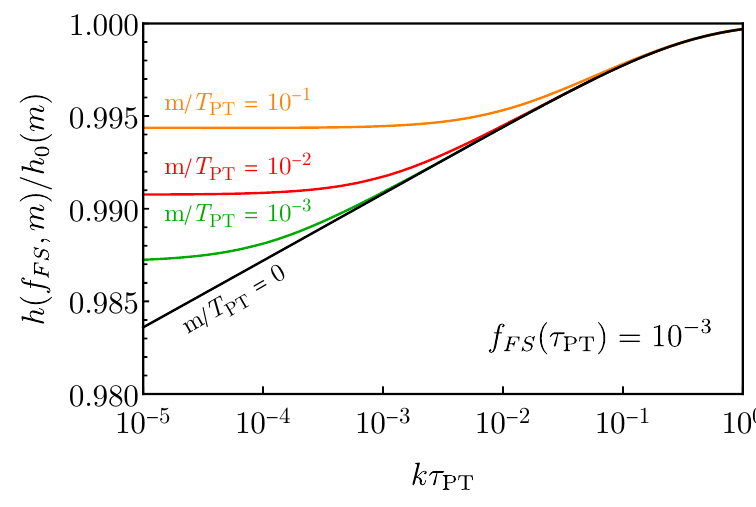
Figure 8 . The fractional suppression of GWs due to massive free streaming particles as compared to massive interacting particles. We fix the free streaming fraction to be f FS ( τ PT ) = 10 − 3 and let the mass vary m/T PT = 10 − 1 , 10 − 2 , 10 − 3 , 0 , shown in orange, red, green and black respectively. When the free streaming particles becomes non-relativistic, they cease to suppress the gravitational waves leaving only the suppression that resulted from back when they were